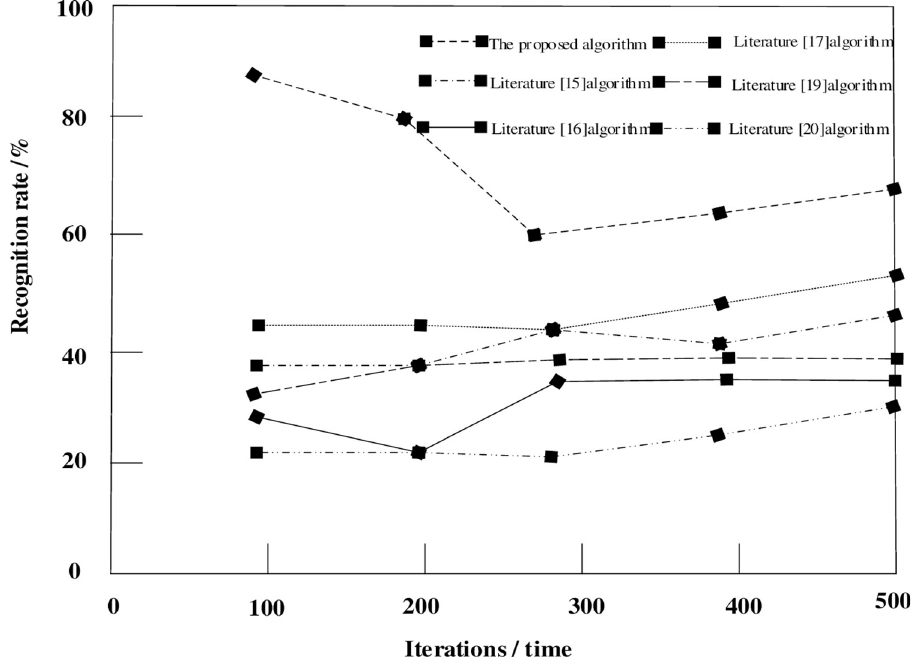
Fig 3. Relationship curve between iteration times and recognition